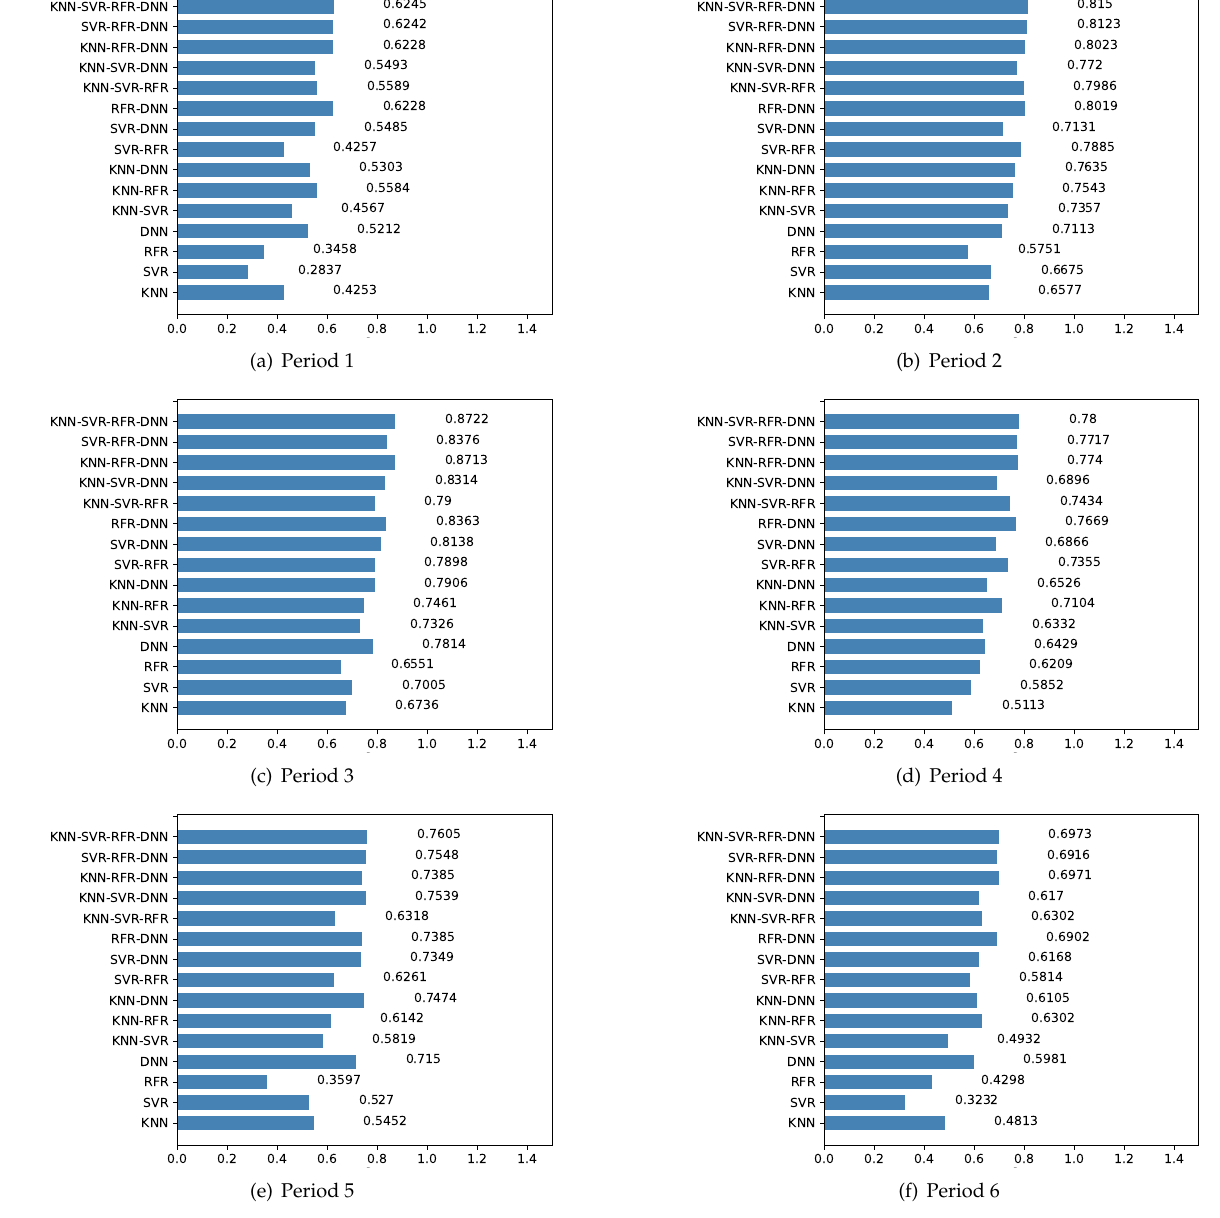
Figure 8. R 2 comparison of different superimposed regression models for six